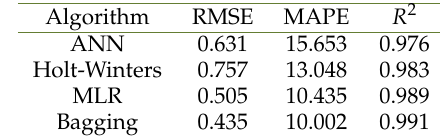
Table 4. Comparison results of accuracy of three evaluation index models.